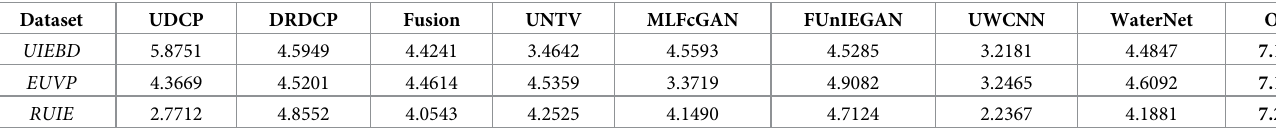
Table 4. UIQM of evaluation results on test datasets.